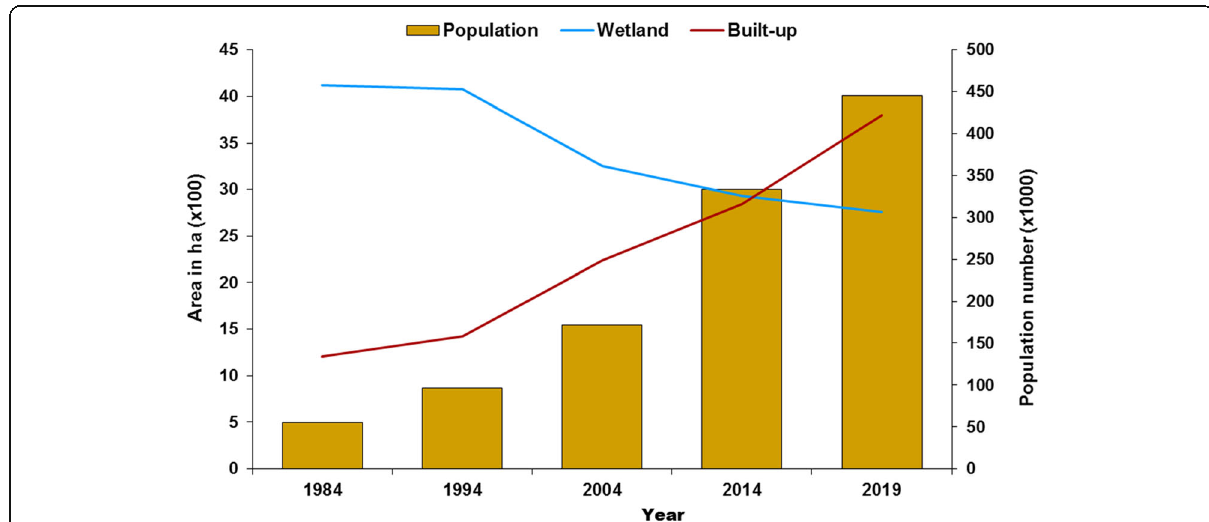
Fig. 4 Wetland shrinkage versus population growth and urban expansion over time in the study area (1984 – 2019). Source (Ethiopian Central Statistics Agency 1984, 1994, 2007, and 2014, 2019 projected